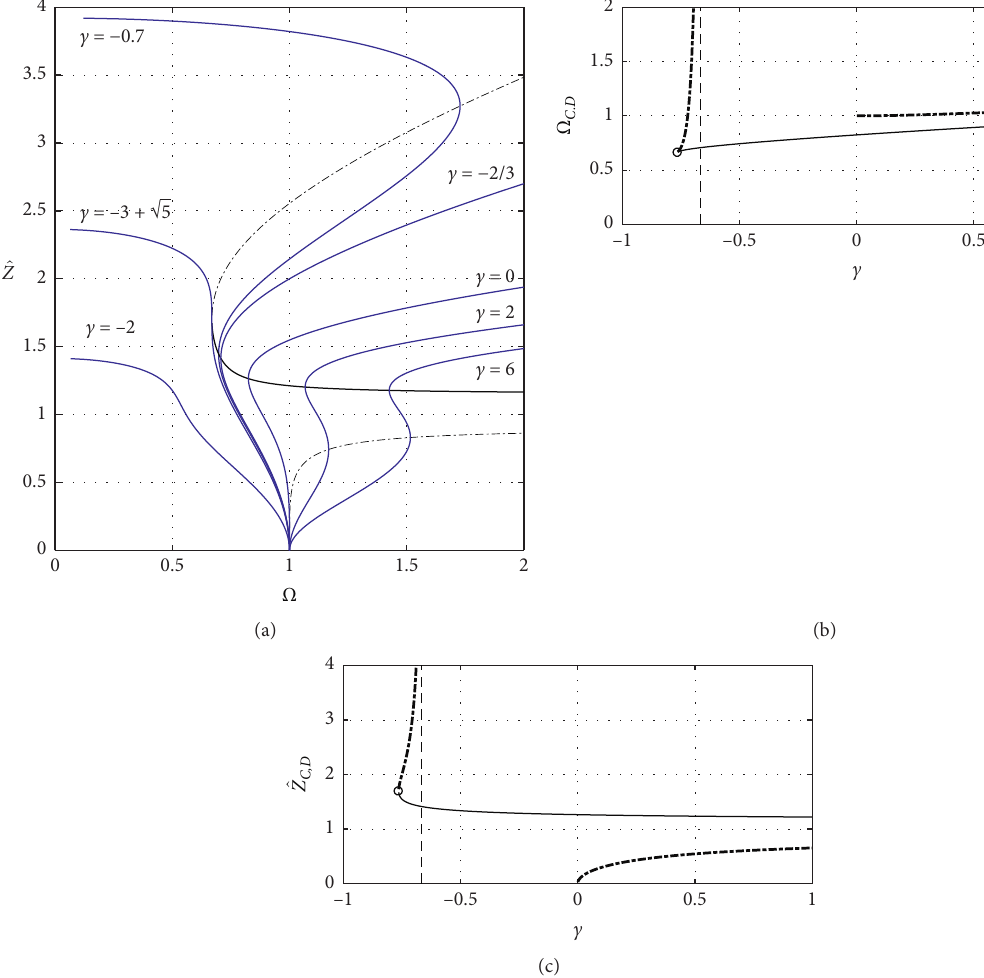
Figure 9: (a) Backbone curves (thick solid lines) for different values of c , as labelled; locus of points C, i.e., relative minima, (thin solid line) and points D, i.e., relative maxima, (thin dash-dotted line). (b) Frequency corresponding to the relative minima (solid line) and maxima (dash-dotted line) as a function of c . (c) Displacement amplitude corresponding to the relative minima (solid line) and maxima (dash-dotted line) as a function of c . The vertical dashed line in (b) and (c) denotes the asymptotic trend for c � − ( 2/3 ) , � √ and the circle denotes the limit for c � − 3 + 5